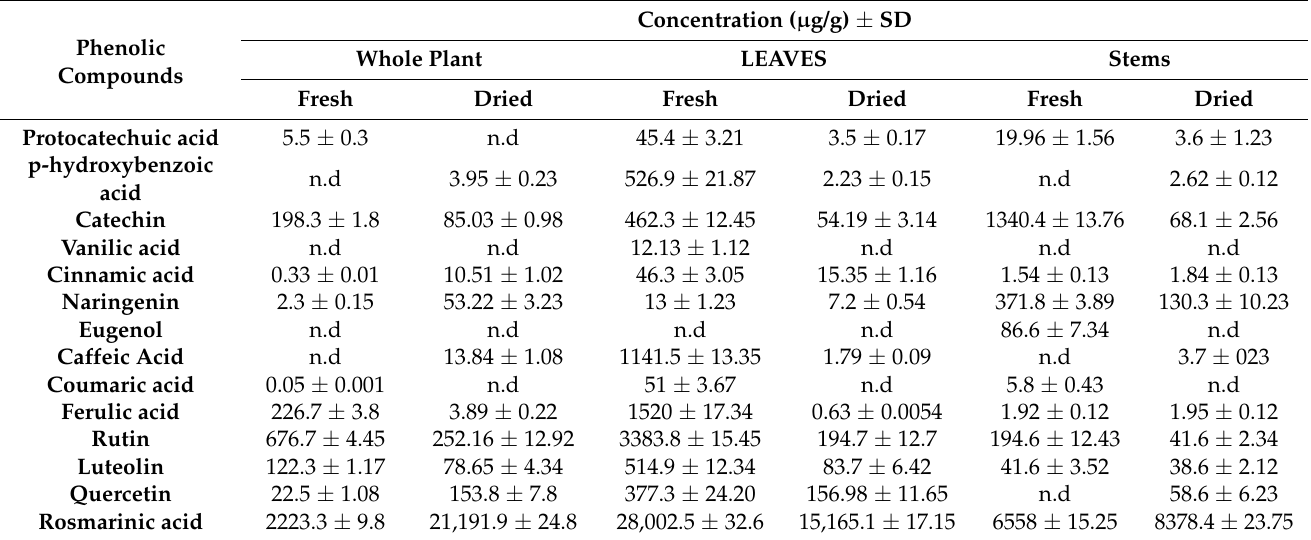
Table 2. The chemical composition of fresh and dried M. suaveolens L . analyzed by using HPLC.